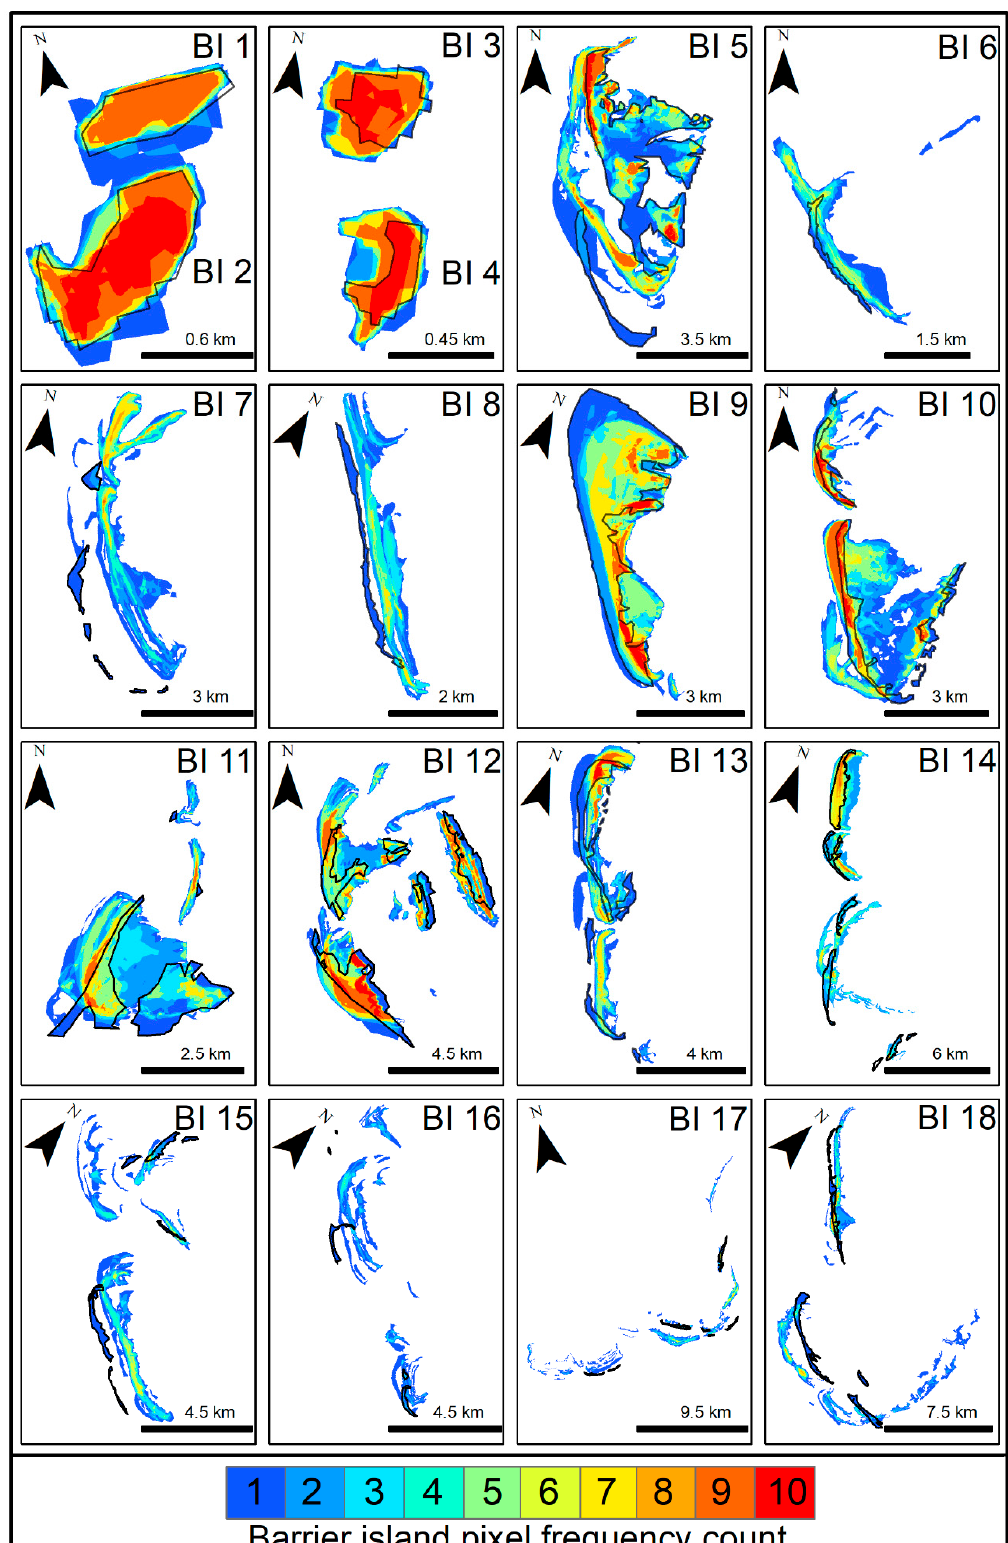
Figure 6. Pixel by pixel frequency. The black colored polygons show the extent of a barrier island in 1976 (for barrier islands 1 to 14) and 1990 (for barrier islands 14 to